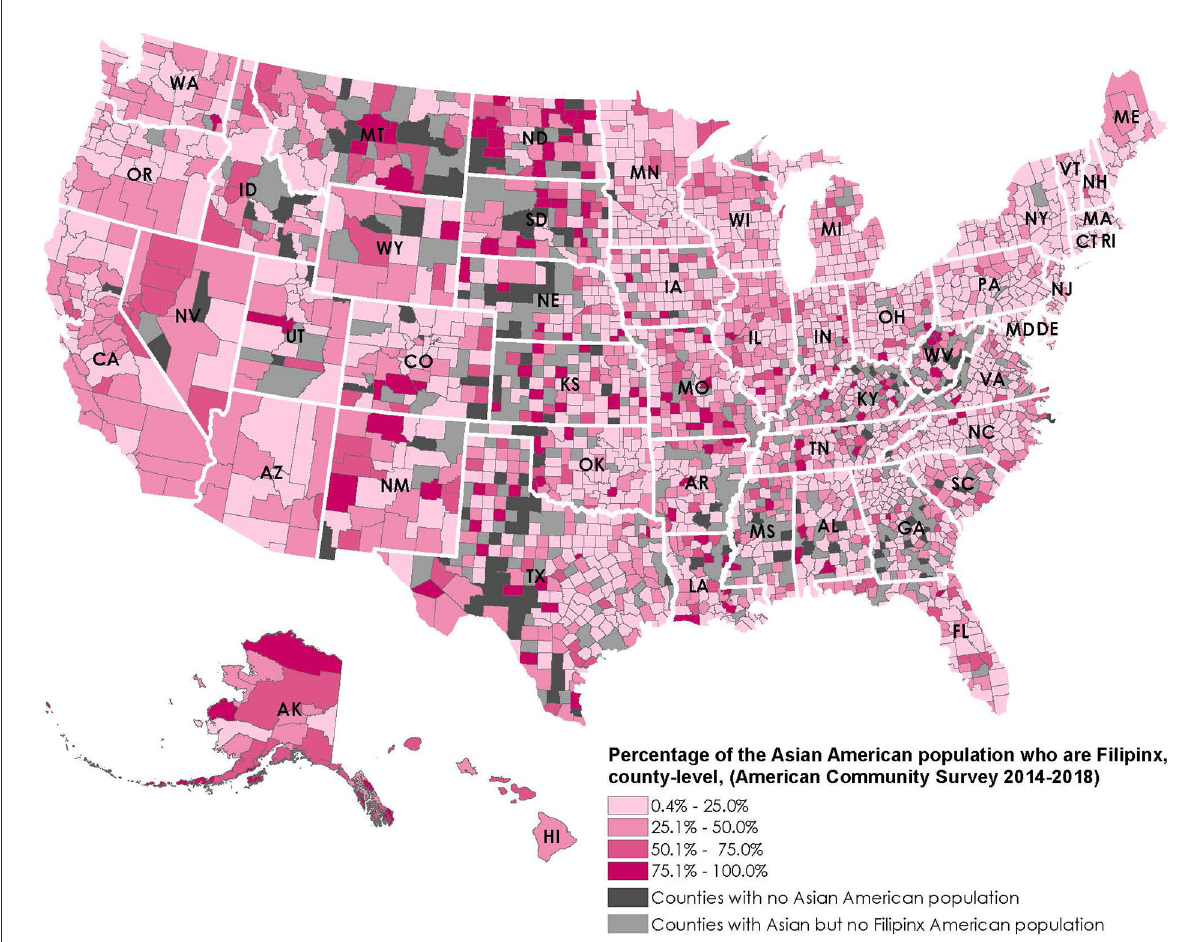
FIGURE2 Percentage of the Asian American population who are Filipinx, county-level, 2014–2018.